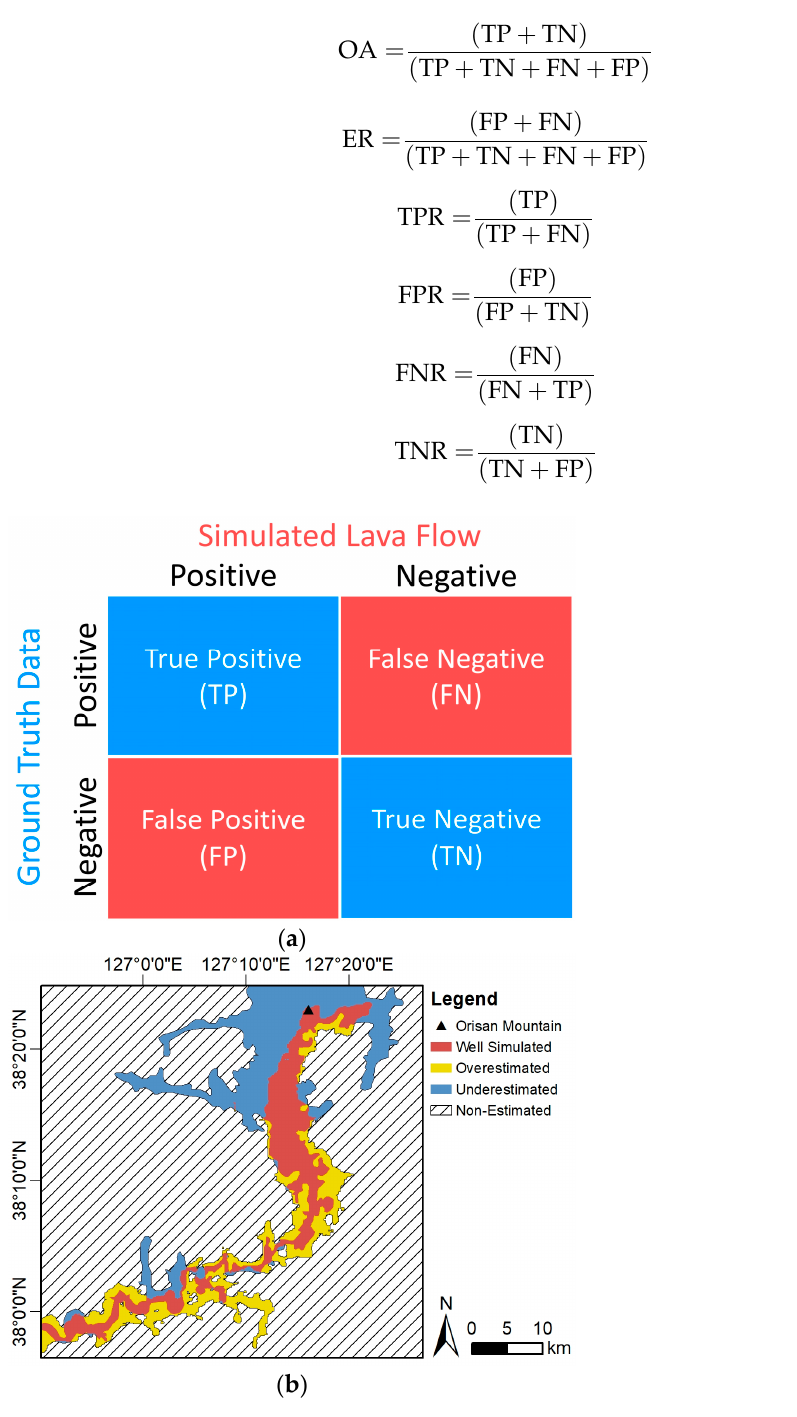
Figure 5. ( a ) Confusion matrix for binary classification; ( b ) schematic representation of the confusion matrix calculation.